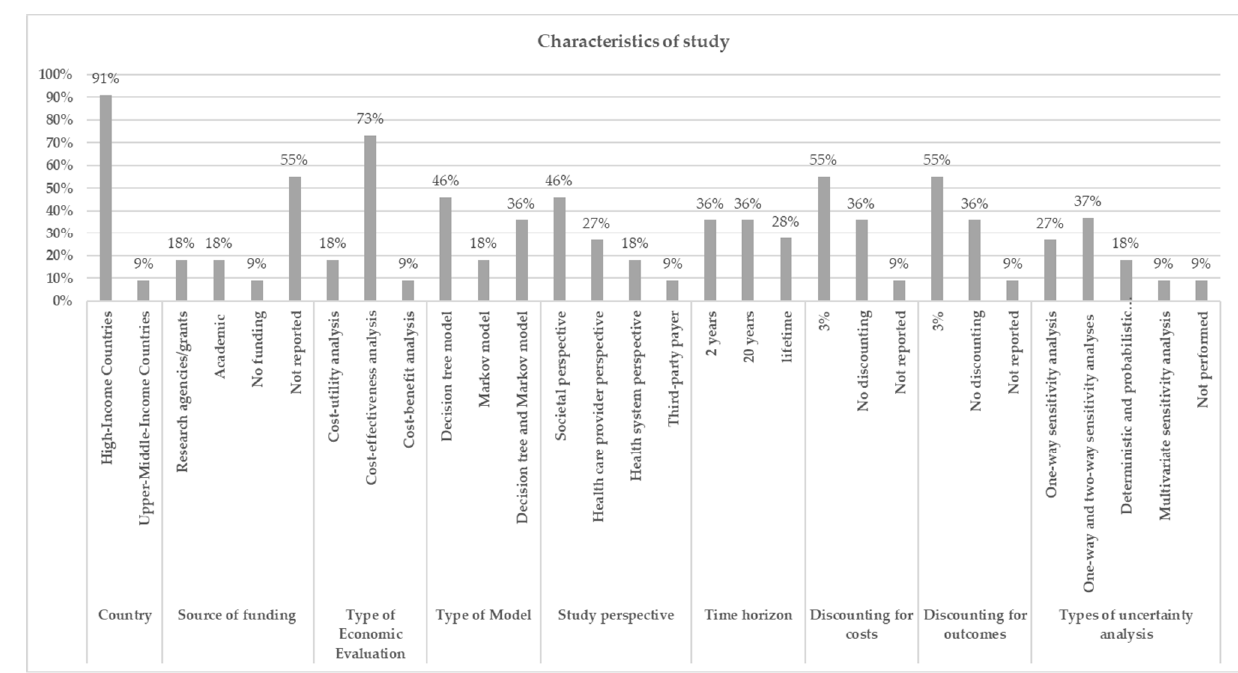
Figure 2. Summary of characteristics and methodologies used in the included studies.